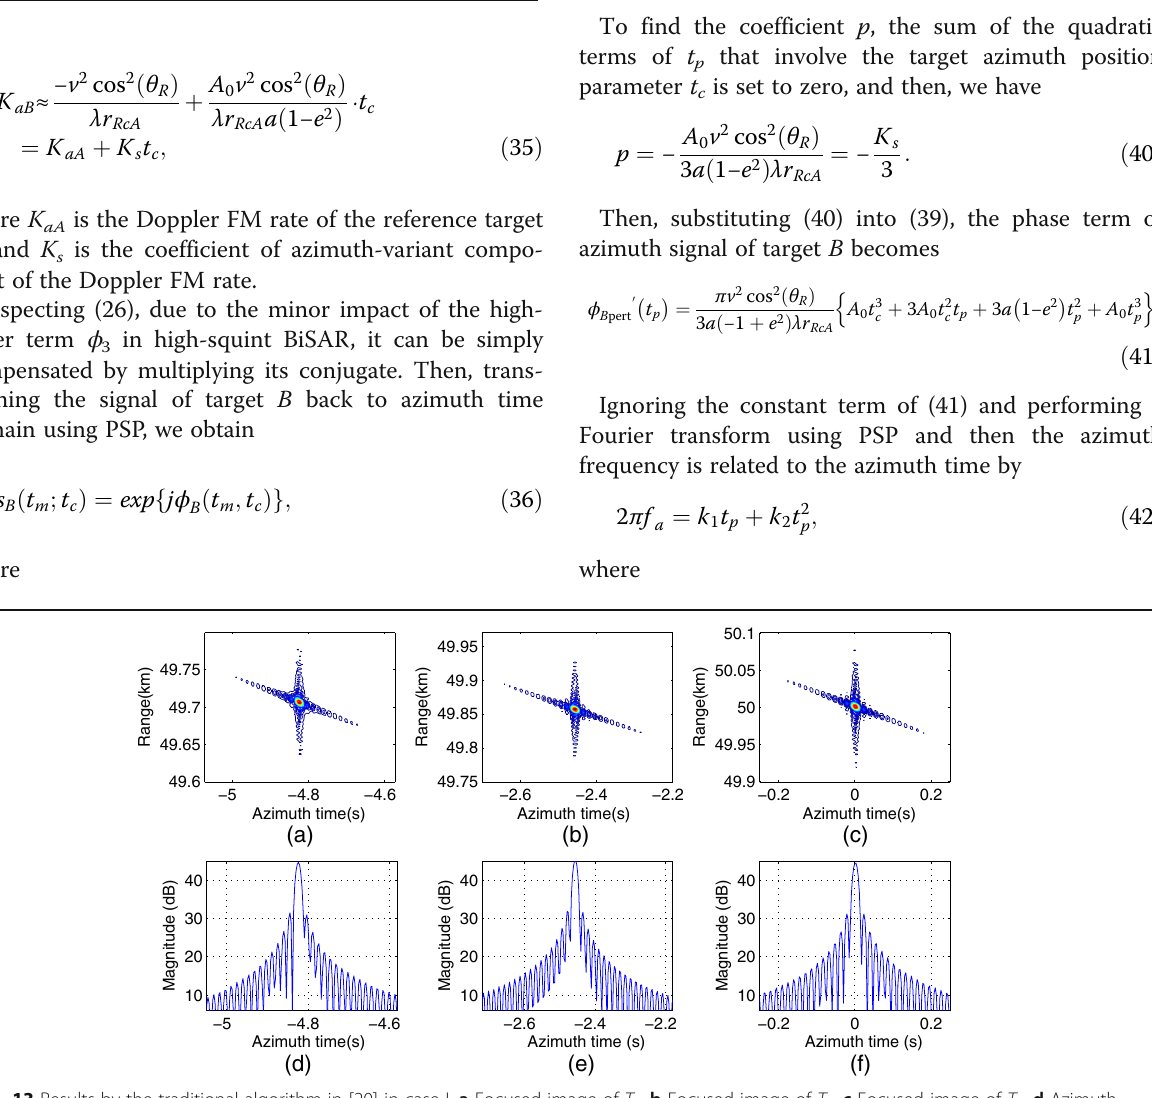
Fig. 13 Results by the traditional algorithm in [20] in case I. a Focused image of T 2 . b Focused image of T 1 . c Focused image of T 0 . d Azimuth profile of T 2 . e Azimuth profile of T 1 . f Azimuth profile of T 0